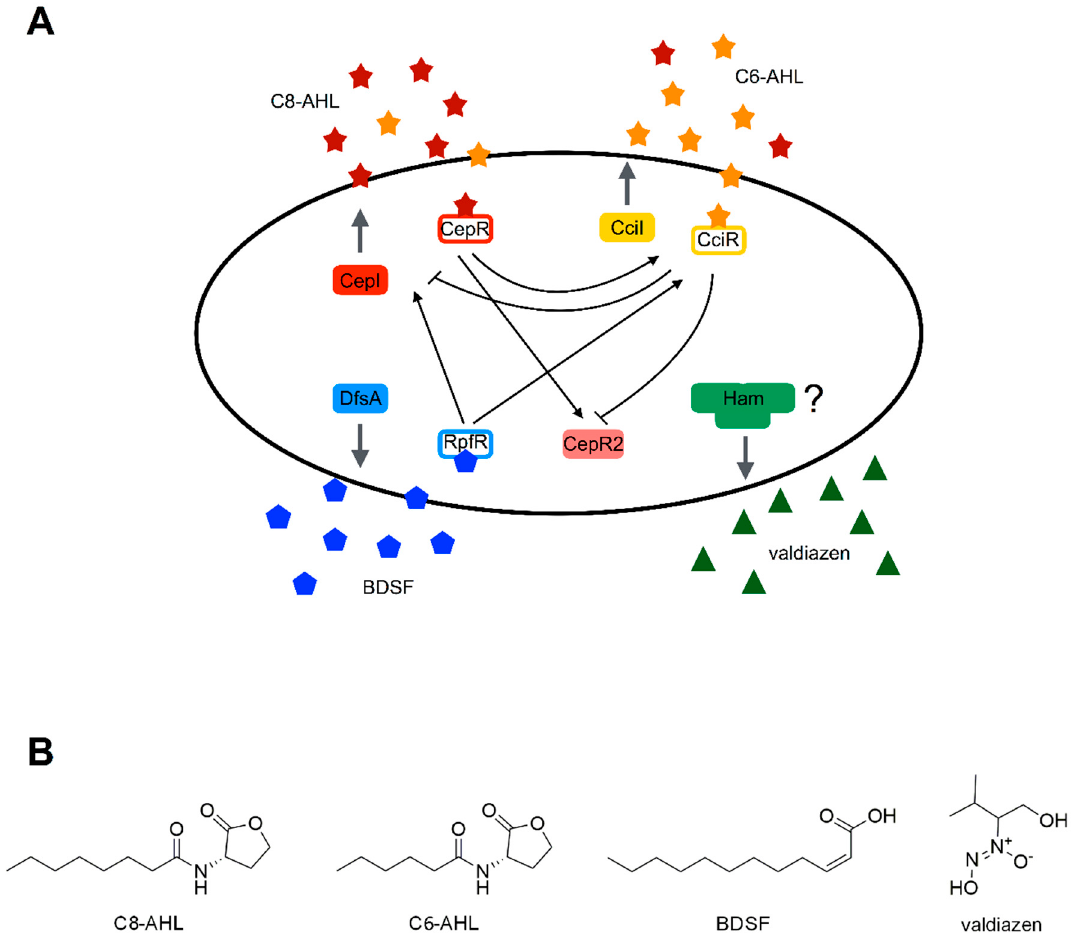
Figure 7. The QS systems of B. cenocepacia , Cep, Cci, Rpf and Ham and their interactions. ( A ) The interactions of the Ham system are not completely elucidated. C8-HSL, N -octanoyl-homoserine-lactone; C6-HSL, N -hexanoyl-homoserine-lactone; BDSF, Burkholderia diffusible signal factor and valdiazen. Arrows indicate positive regulation, T-bars negative regulation. ( B ) Chemical structures of QS signal molecules.